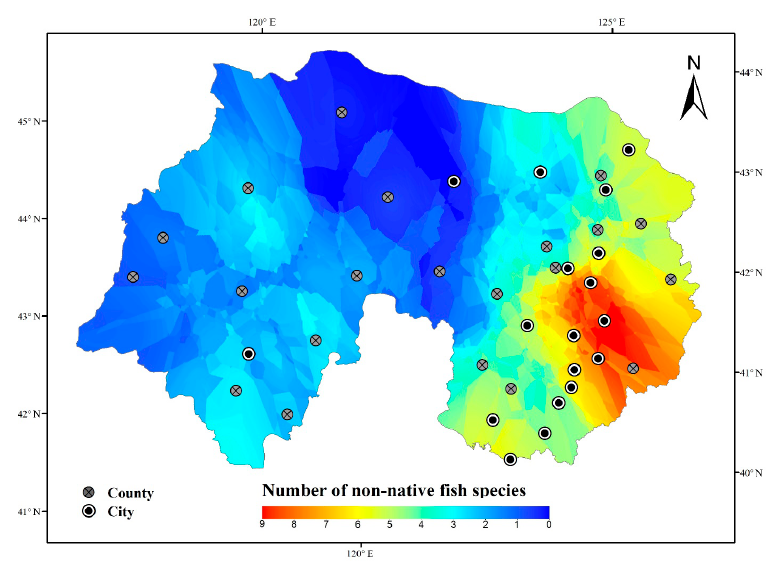
Figure 2. Distribution of non-native fish species in the Liao River Basin.